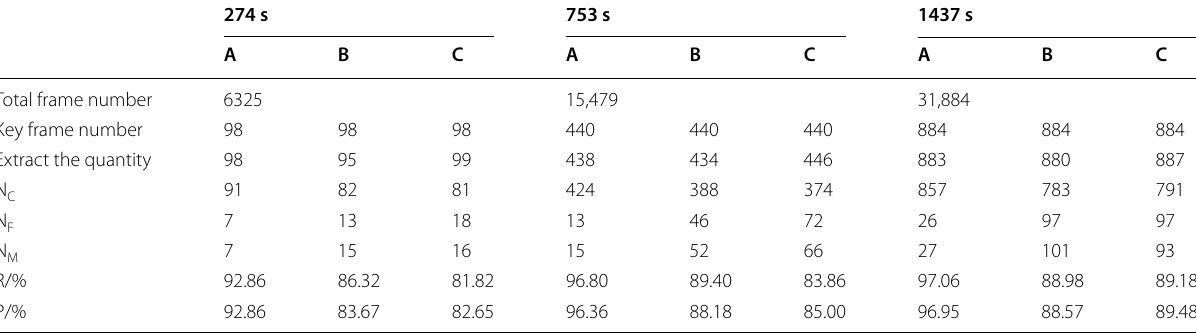
Table 1 Comparative analysis of key frame extraction results of different algorithms 274 s 753